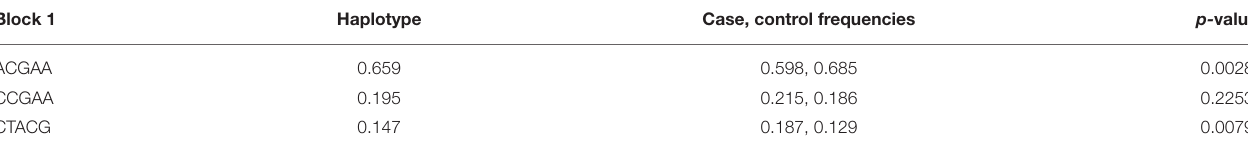
TABLE 4 | Association analyses of the haplotype block with critical COVID-19 hospital presentation. Block 1